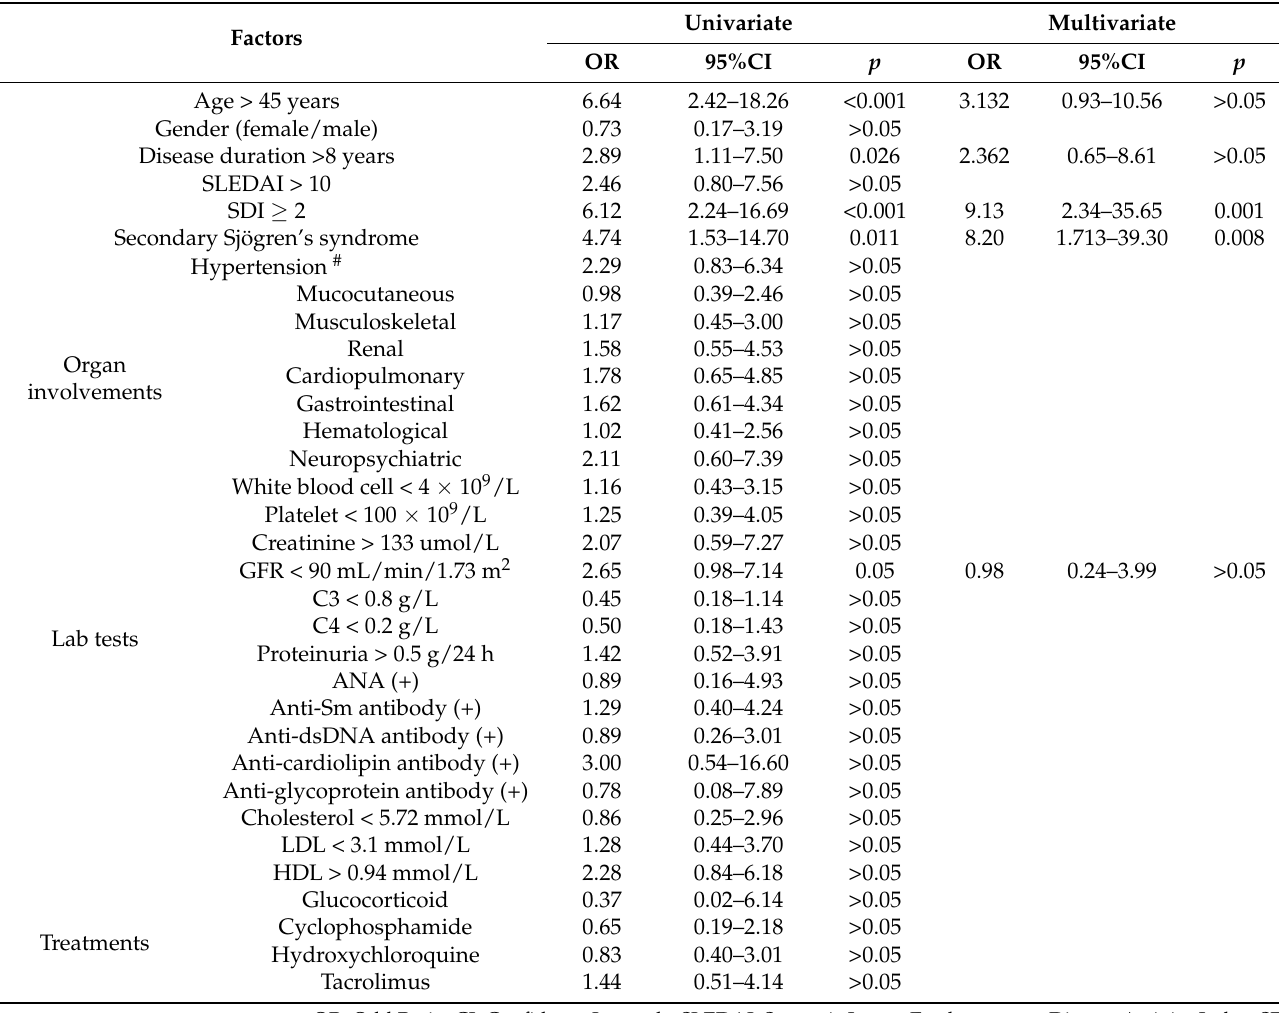
Table 2. Factors related to hearing loss in SLE patients (by logistic